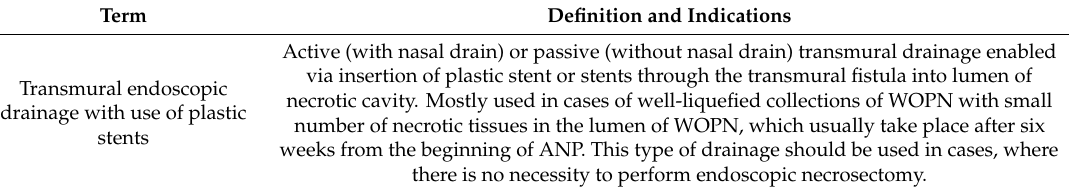
Table 2. Definitions